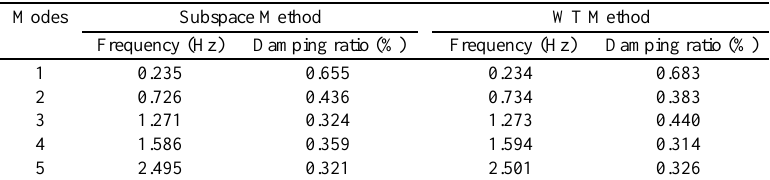
Table 1 Natural frequencies and damping ratios using the subspace method and the WT